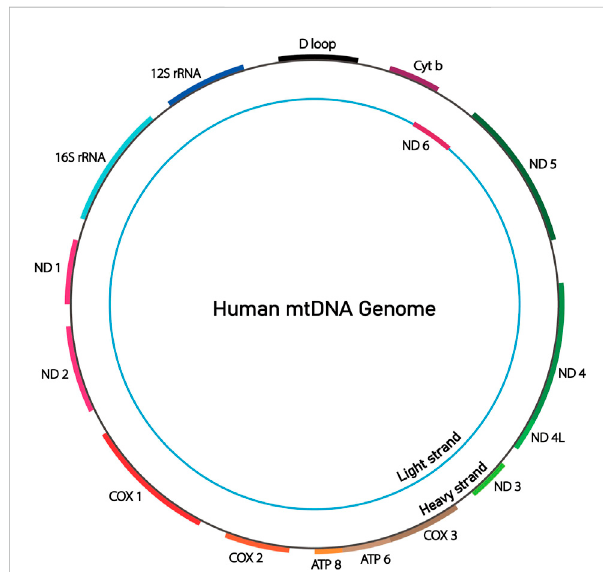
FIGURE 2 This is a diagram of the mitochondrial genome. It encodes for 13essentialproteinsinvolvedinrespiratorychainelectrontransferand oxidativephosphorylation.ND1,ND2,ND3,ND4,ND4L,ND5,ND6are subunitsofcomplexI.CytbissubunitofcomplexIII.COX1,COX2, COX3 are subunits of complexIV. ATP8 and ATP6 are subunits of complexV. It also encodes for 22 transfer RNAs (tRNAs) and 2 ribosomal RNAs (rRNAs) that are necessary for protein synthesis within the